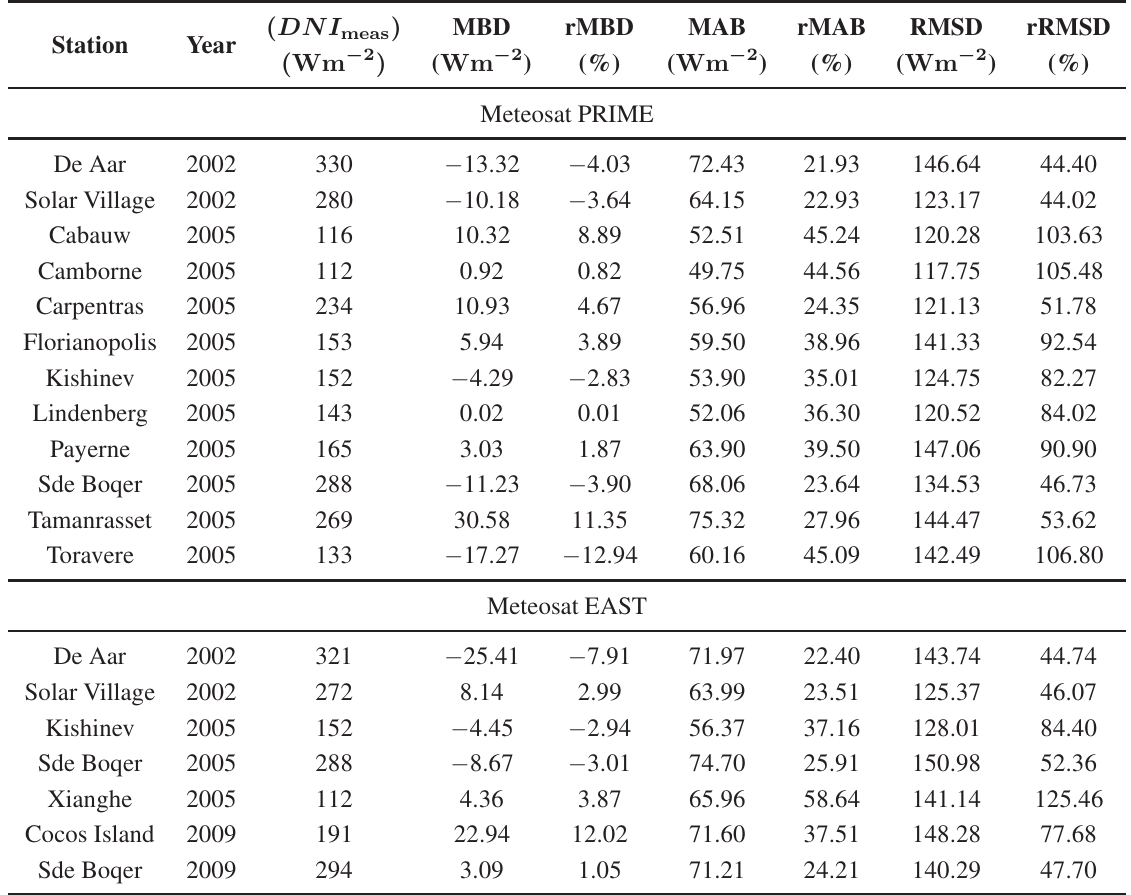
Validation of the satellite-based retrieval of direct normal irradiance, DNI